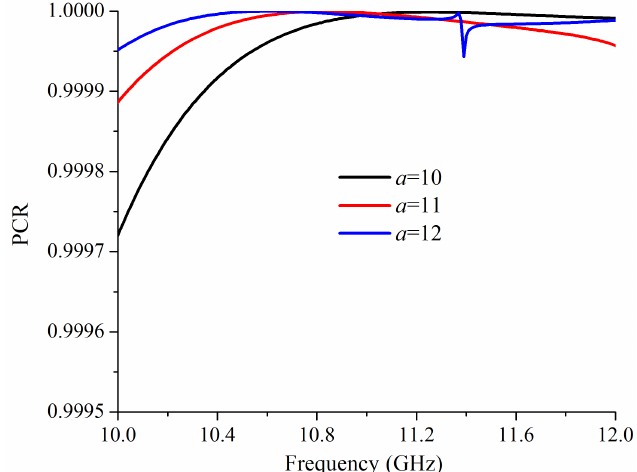
Figure 4. Simulation results with different a : ( a ) The simulated cross-polarized transmittance and reflectance. ( b ) The simulated co-polarized transmittance.